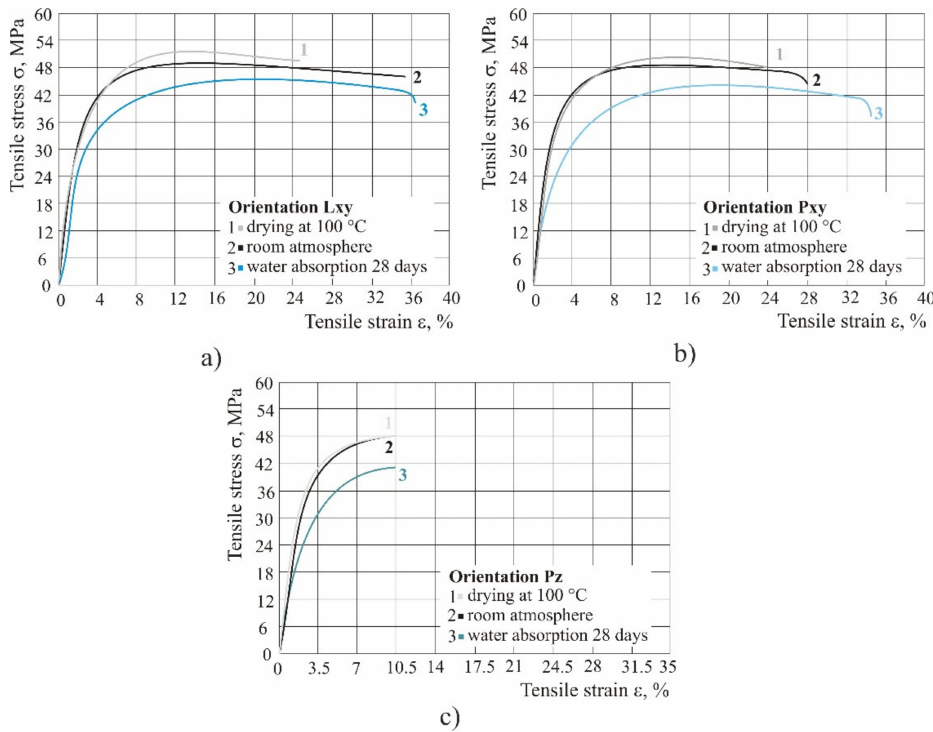
Figure 6. Comparison of different weathering conditions (dry, normal and 100% humid atmosphere):